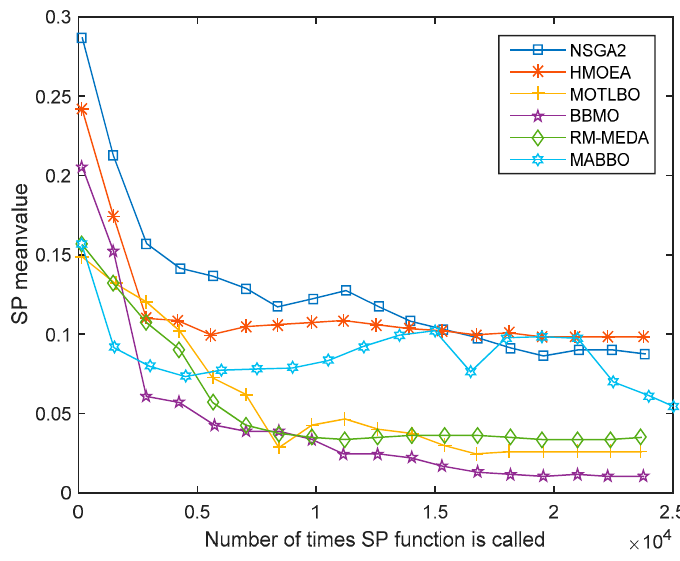
Figure 4. The SP index of six algorithms on DTLZ2 test problem.